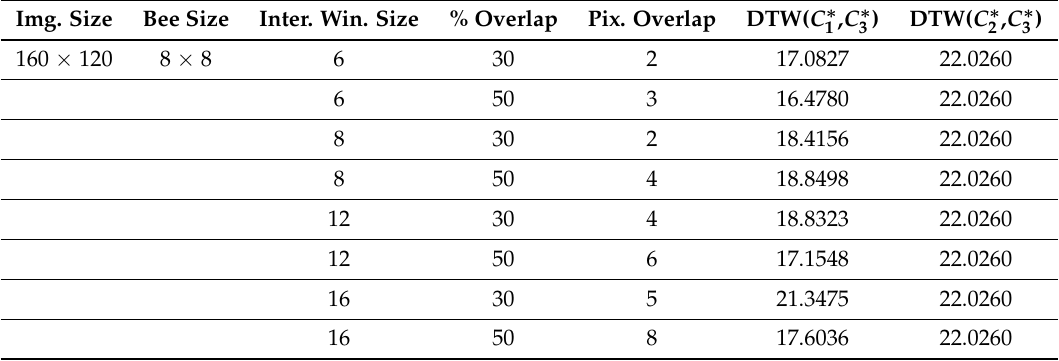
Table A12. DTW values for HT _ Vid . mp 4 with image size of 160 × 120; C ∗ and C ∗ is Human Count (ground truth). 3 Img. Size